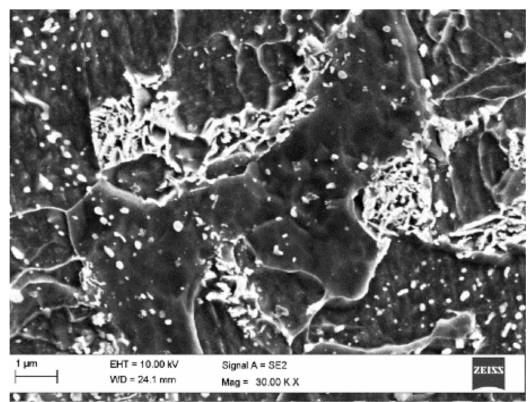
Figure 20. Carbide concentrations in detail from location D of the HAZ of S690QL produced with the high heat input weld (t 8/5 = 20